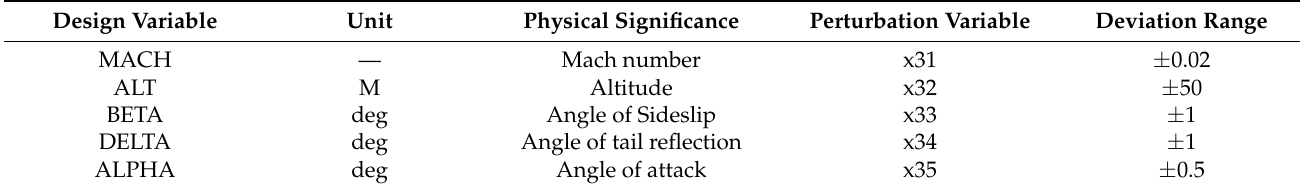
Table 3. Range and category of flight condition uncertain